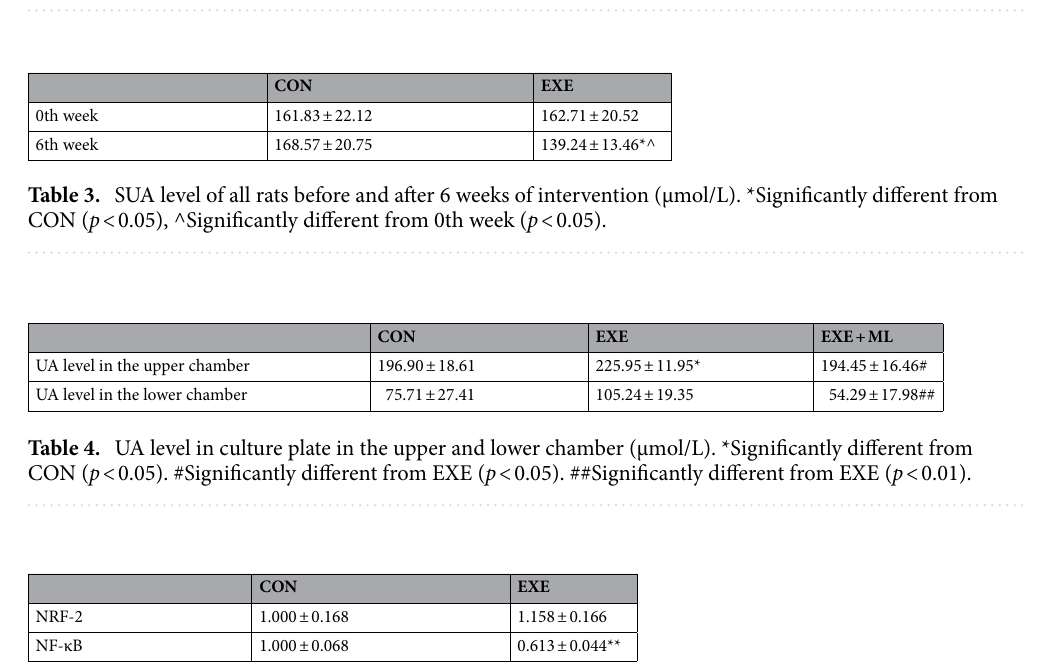
Table 5. NF-κB and NRF-2 protein expression of rat’s kidney. **Significantly different from CON ( p <